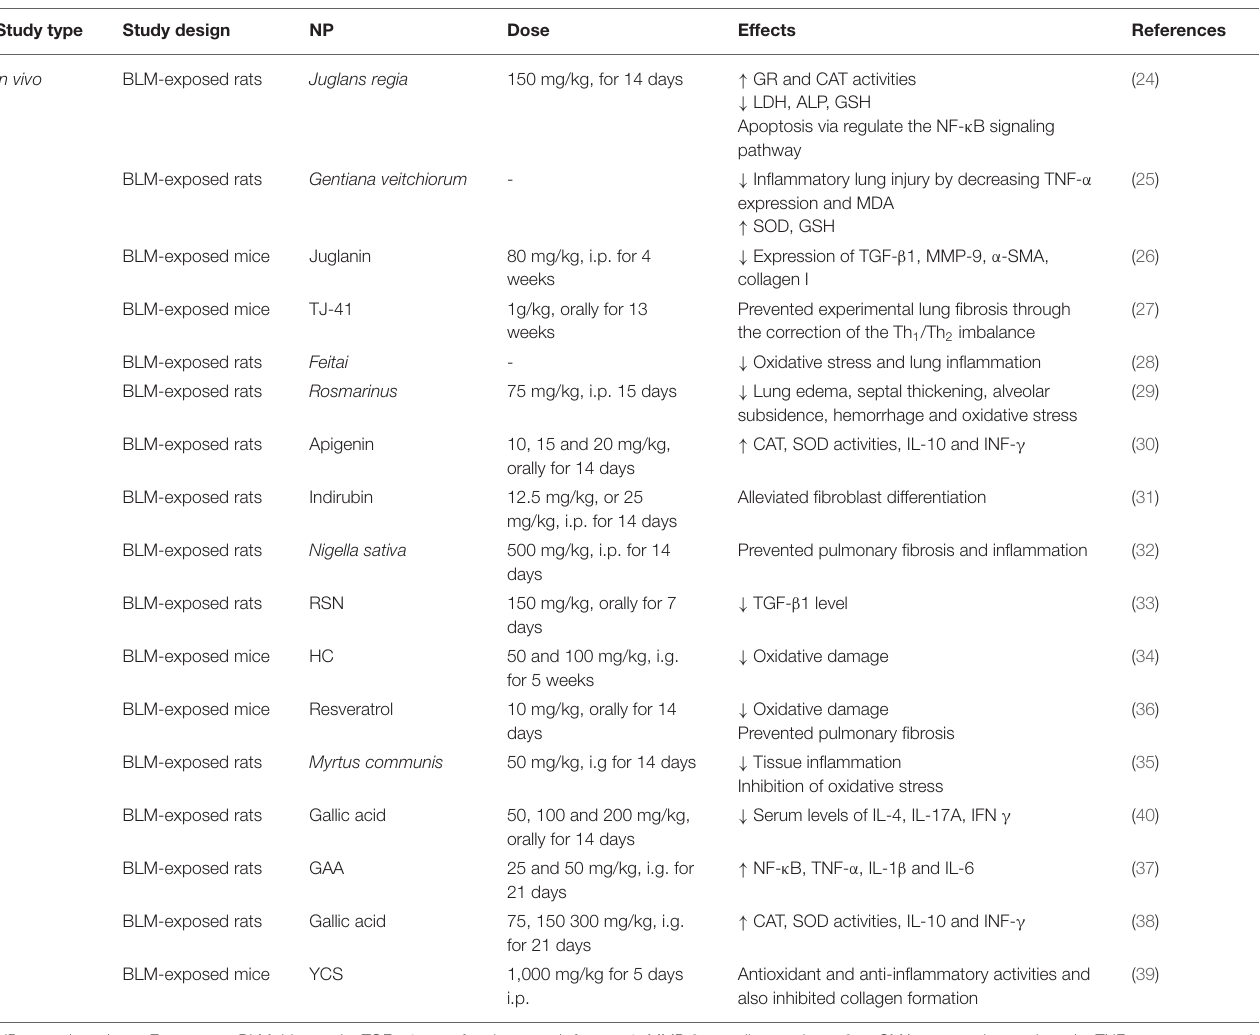
TABLE 1 | The possible therapeutic effects of NP in the BLM-induced lung